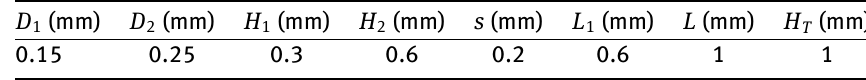
Table 1: Heat sink dimensions used for the code validation process